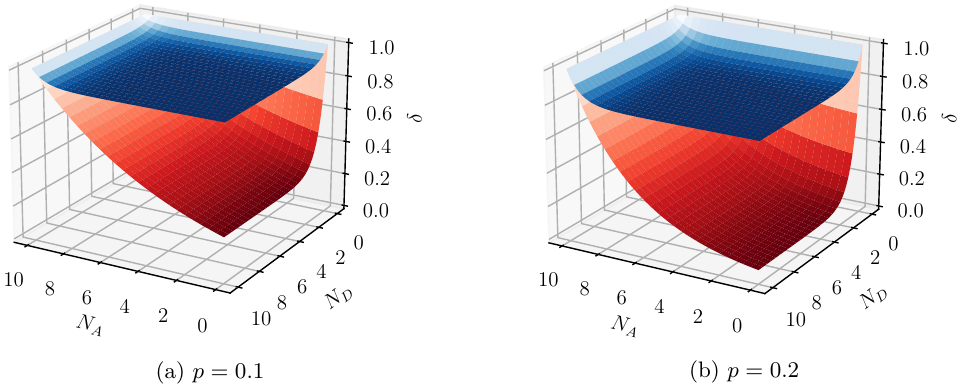
Figure 2 . The Haar random average of error factor δ due to the erasure errors (red surface) and the decoherence (blue surface) in the storage. Without errors the error factor satisfies δ = 1 . Total system size is N = 10 , and the subsystem sizes are given by N A and N D . The erasure error induces bigger depletion in δ than the